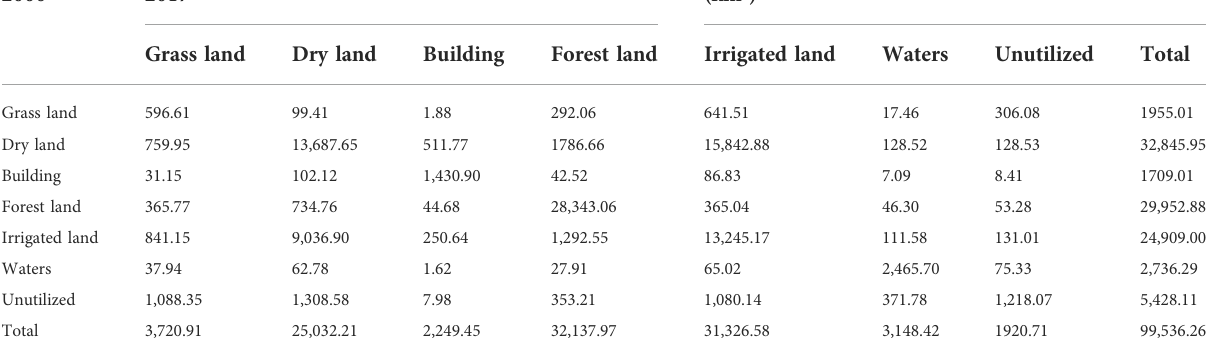
TABLE 5 Land use transition matrixes between 2000 and